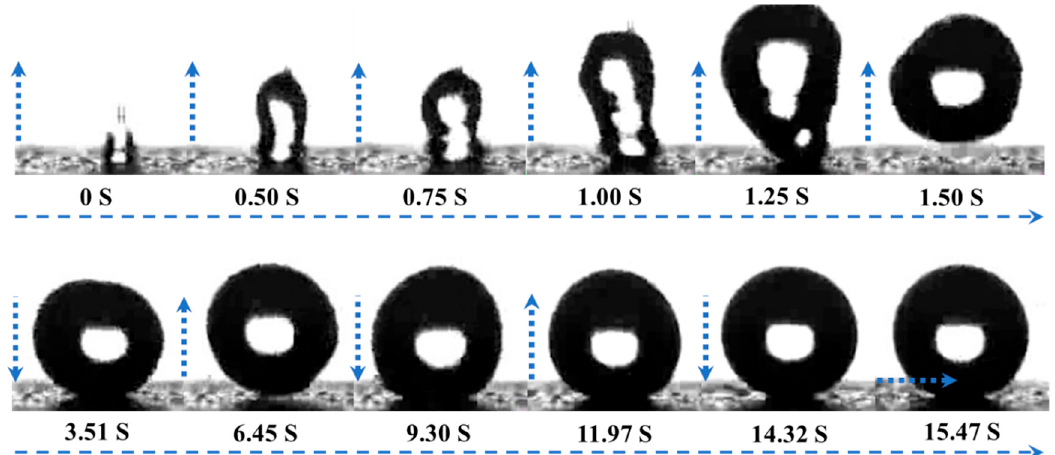
Figure 6. Bouncing of a water droplet on the surface of a methylated silica coating.